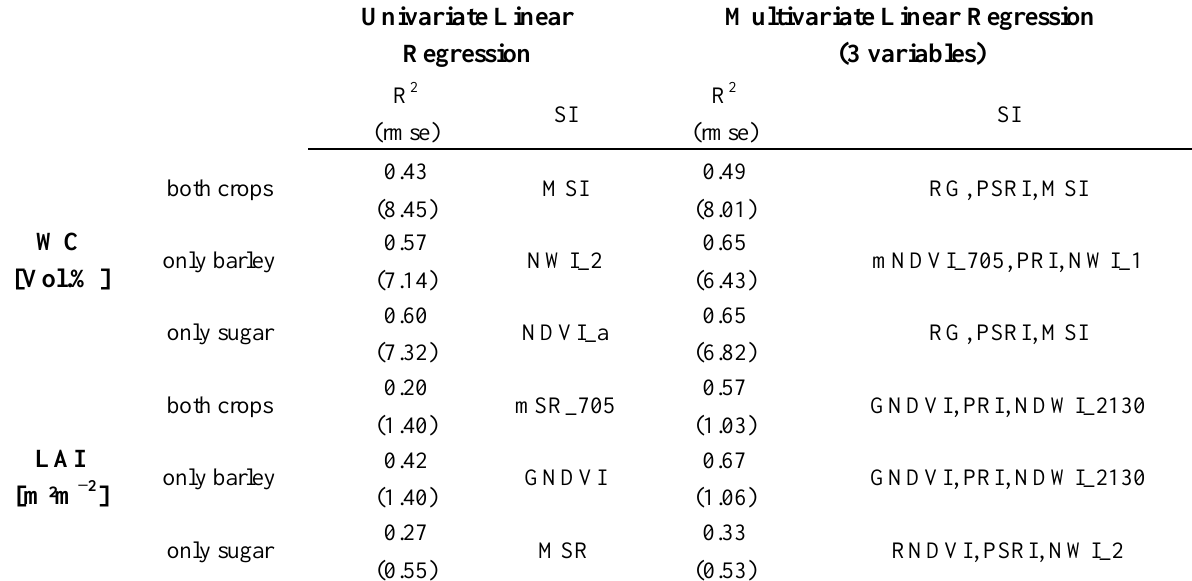
Table 4. Coefficients of determination ( R 2 ) and root mean square error (rmse, in brackets) of simple univariate and multiple (three-fold) linear regressions between LAI/WC and pre-selected SI’s (see Table 1). Values listed are the maximum R² values and the corresponding root mean square error ( rmse ) when varying through all 28 indices for univariate linear regression and through all combinations of SI’s (one from each of the three functional groups, see Table 1) for multiple linear regression. This analysis has been performed using data for “both crops” (Spring Barley and Sugar Beet) together as well as separately (“only barley” and “only sugar”). The columns “SI” refers to the spectral index (see Table 1) achieving the best